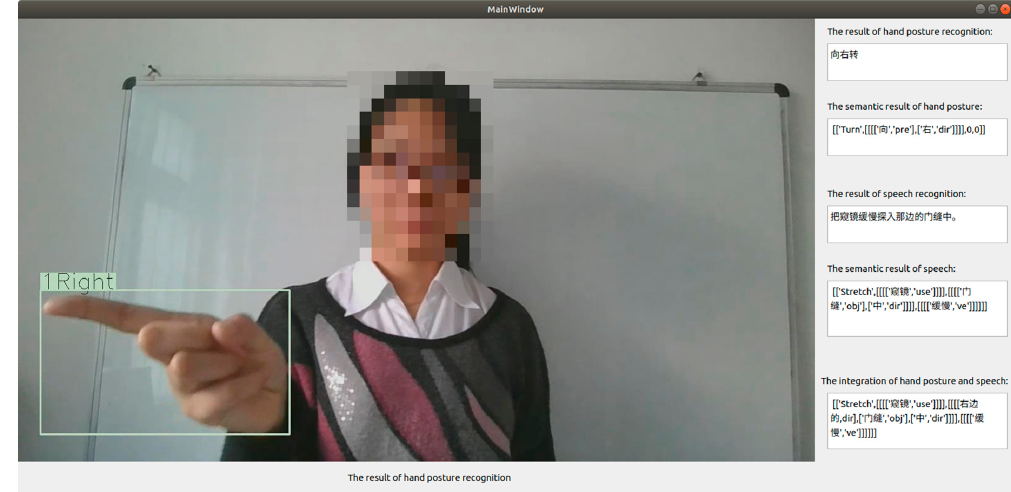
Figure 23. Results of the integration of deictic hand posture and voice commands.